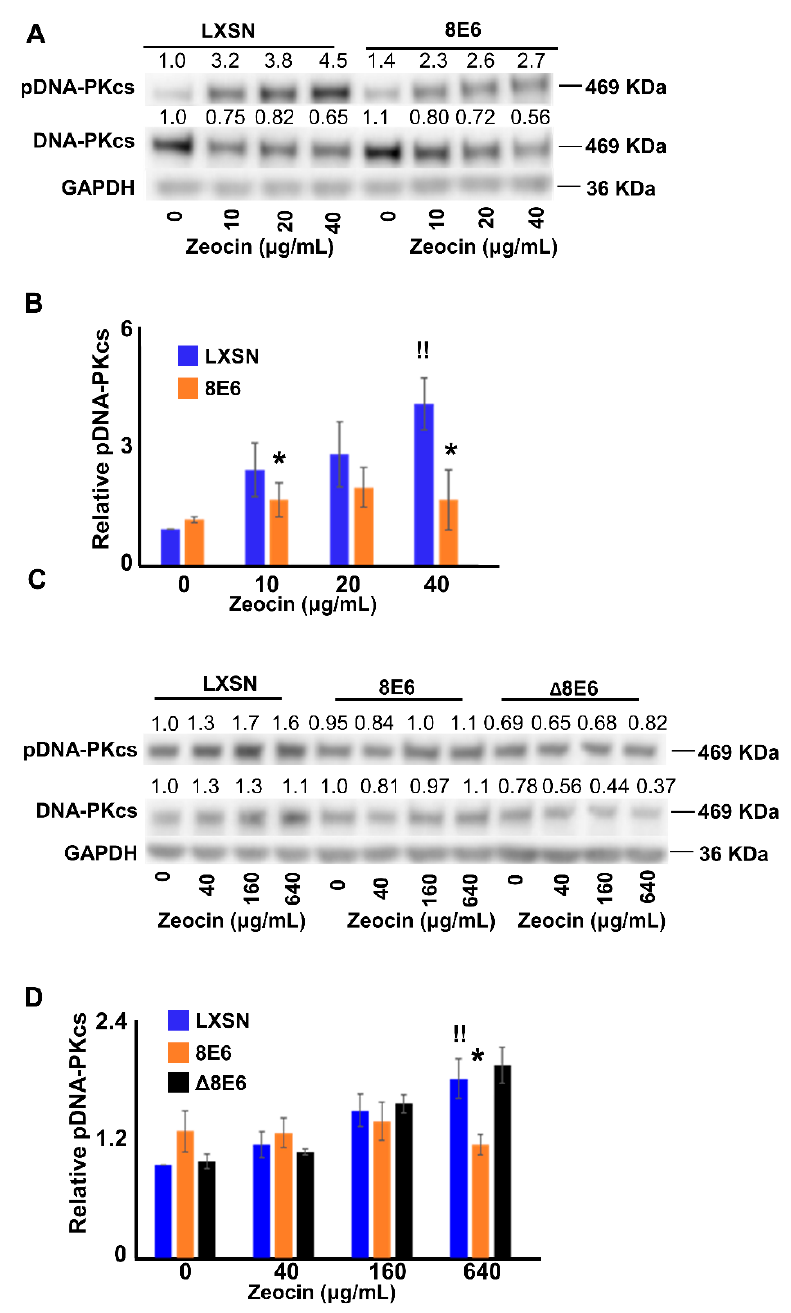
Figure 2. β -HPV 8E6 attenuates DNA-PKcs phosphorylation. ( A ) Representative immunoblot showing phospho-DNA-PKcs (pDNA-PKcs) and total DNA-PKcs in HFK LXSN and HFK β -HPV 8 E6. ( B ) Densitometry of immunoblots of pDNA-PKcs normalized to total DNA-PKcs and GAPDH as a loading control. ( C ) Representative immunoblot showing pDNA-PKcs and DNA-PKcs in U2OS LXSN, U2OS β -HPV 8 E6, and U2OS β -HPV ∆ 8 E6. ( D ) Densitometry of immunoblots ( n = 4) of pDNA-PKcs normalized to total DNA-PKcs and GAPDH as a loading control. All values are represented as mean ± standard error from at least three independent experiments. Statistical di ff erences between groups were measured by using Student’s t -test. * indicates p < 0.05. !! indicates significant di ff erence between Zeocin treated and untreated